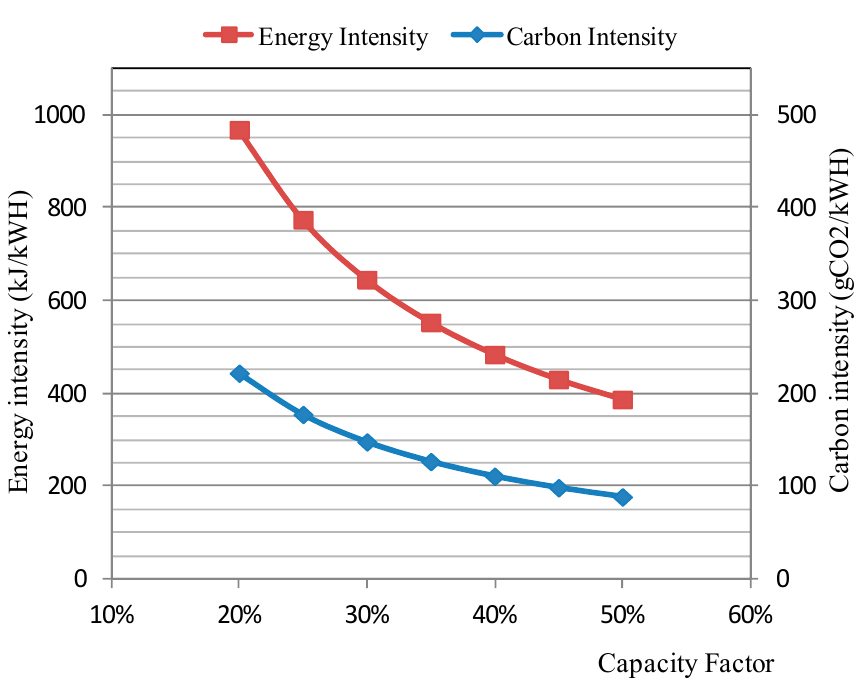
Figure 6. Carbon and energy intensities depending on capacity factors.